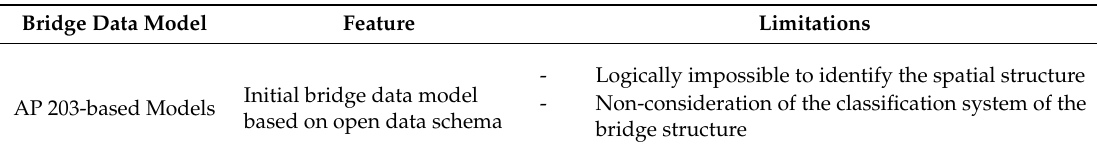
Table 1. Bridge data model comparisons mentioned in this study. IFC: Industry foundation classes; PSETs: property sets; BIM: building information modeling.